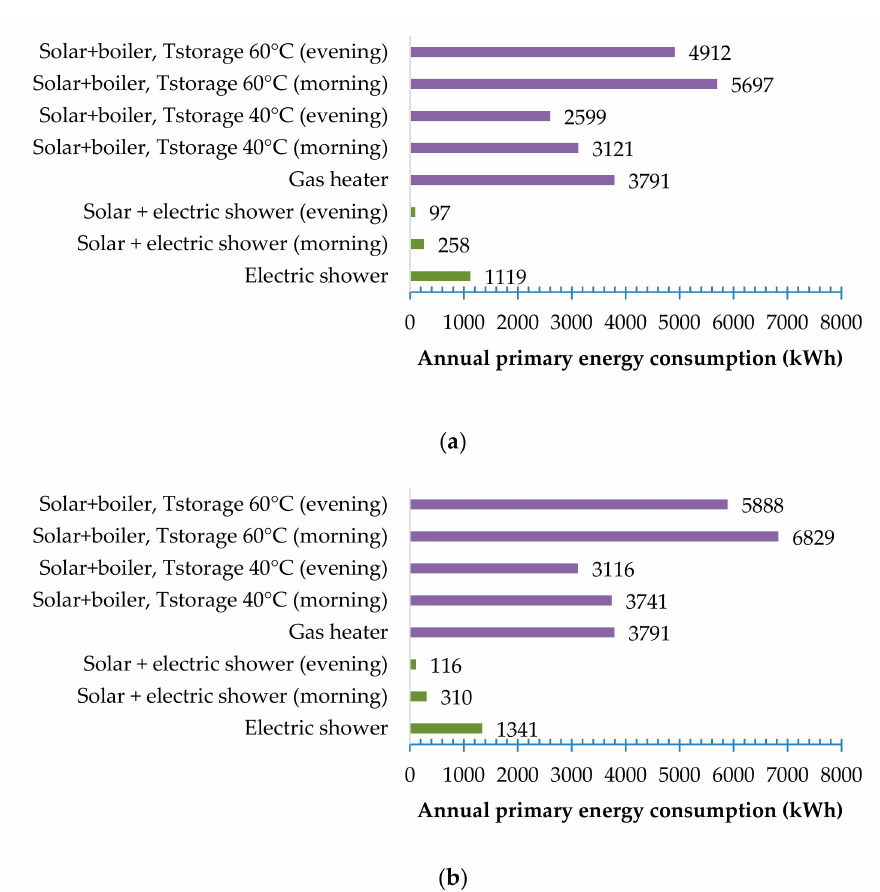
Figure 12. Annual primary energy consumption for water heating in Bras í lia. ( a ) Current scenario; ( b ) critical